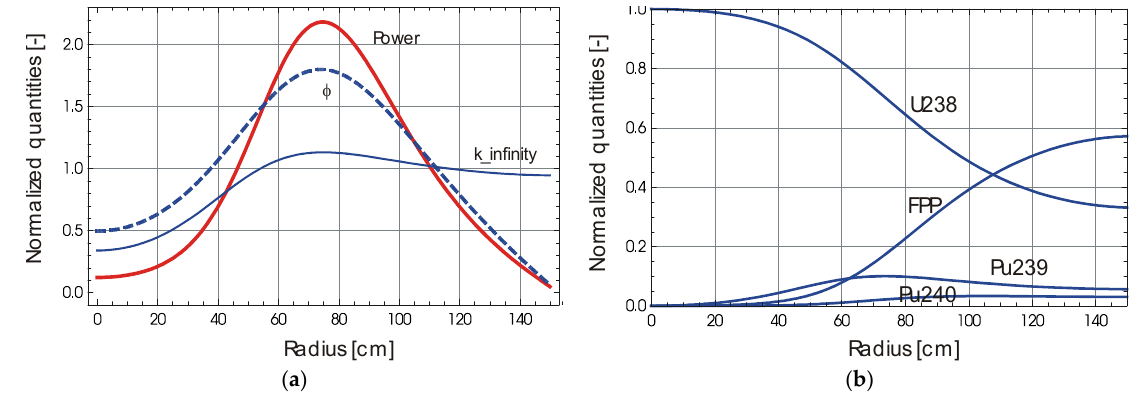
Figure 6. Distributions of ( a ) power, neutron flux and k of radial outward fuel